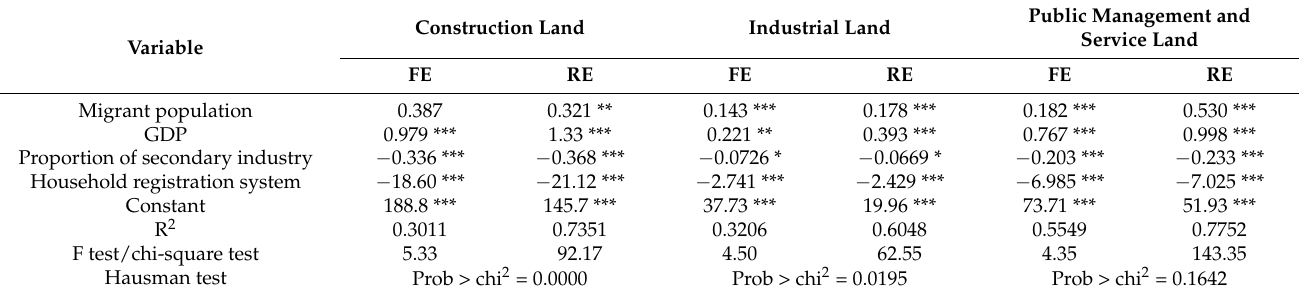
Public Management and Service